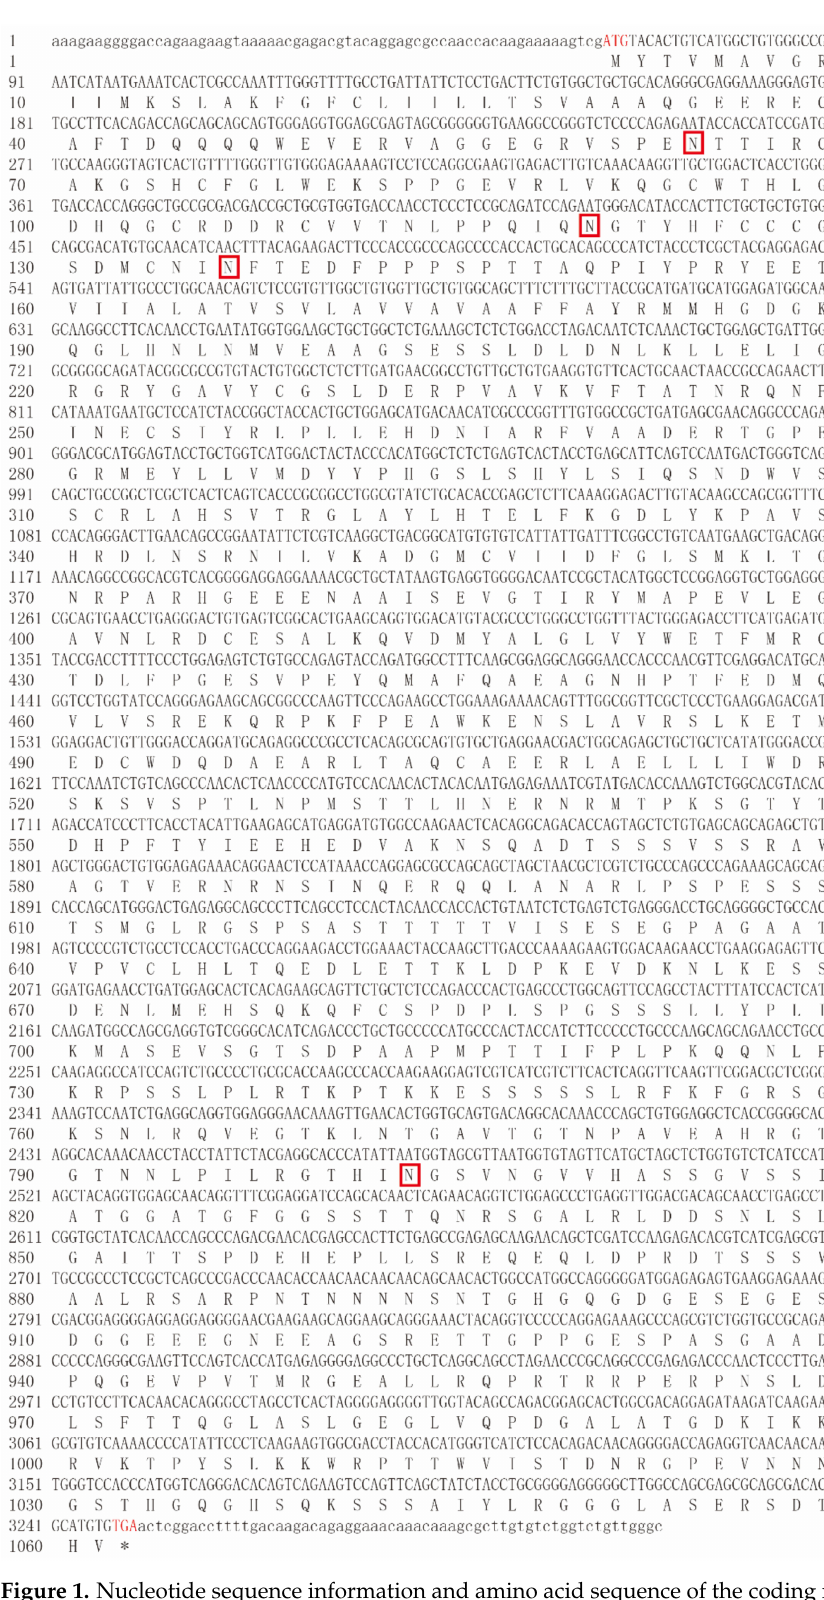
Figure 1. Nucleotide sequence information and amino acid sequence of the coding region of Bmpr2 in ricefield eel, Monopterus albus . The untranslated regions and translated regions are indicated by lowercase letters and uppercase letters, respectively. The predicted N-glycosylation sites are red boxes. The initiation codon (ATG) and stop codon (TAA) are marked in red color. Asterisks (*) indicate the translation stop